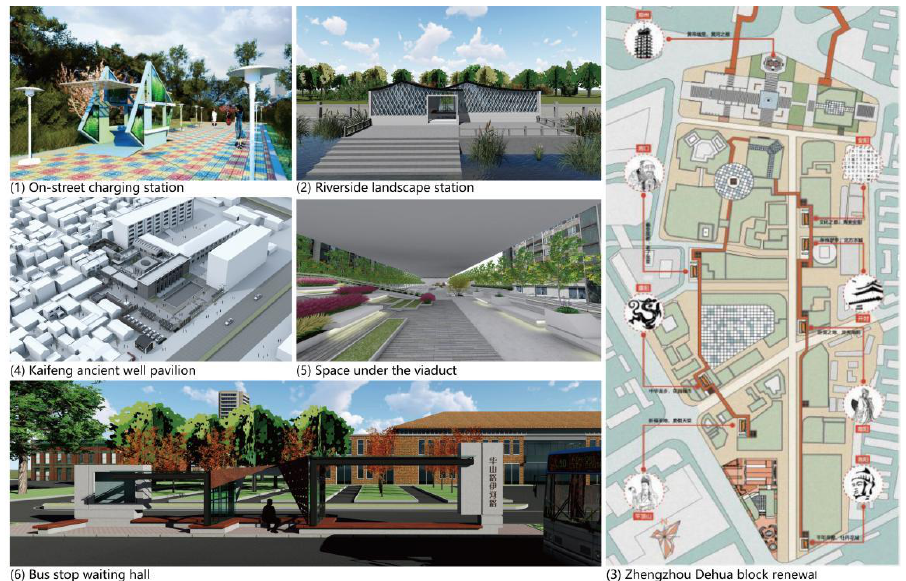
Figure 2. Zhengzhou vulnerable space renewal design scheme.